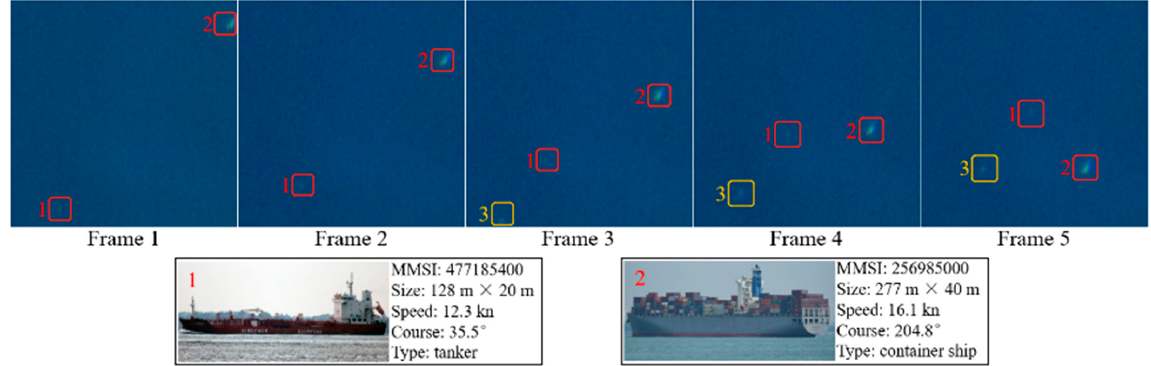
Figure 2. Moving ships in GF-4 sequential image chips (displayed as false-color composites) and corresponding automatic identi fi cation system (AIS) information. The lifetimes of two ships in two red boxes run through the entire image sequences, while the ship in yellow box is treated as a new target.